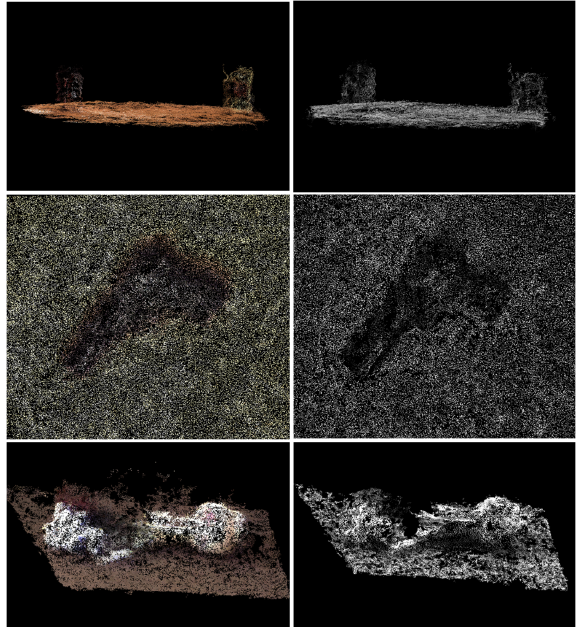
Figure 9. Examples of objects reconstructed in 3D with original (left) and pre-processed (right) panoramas.